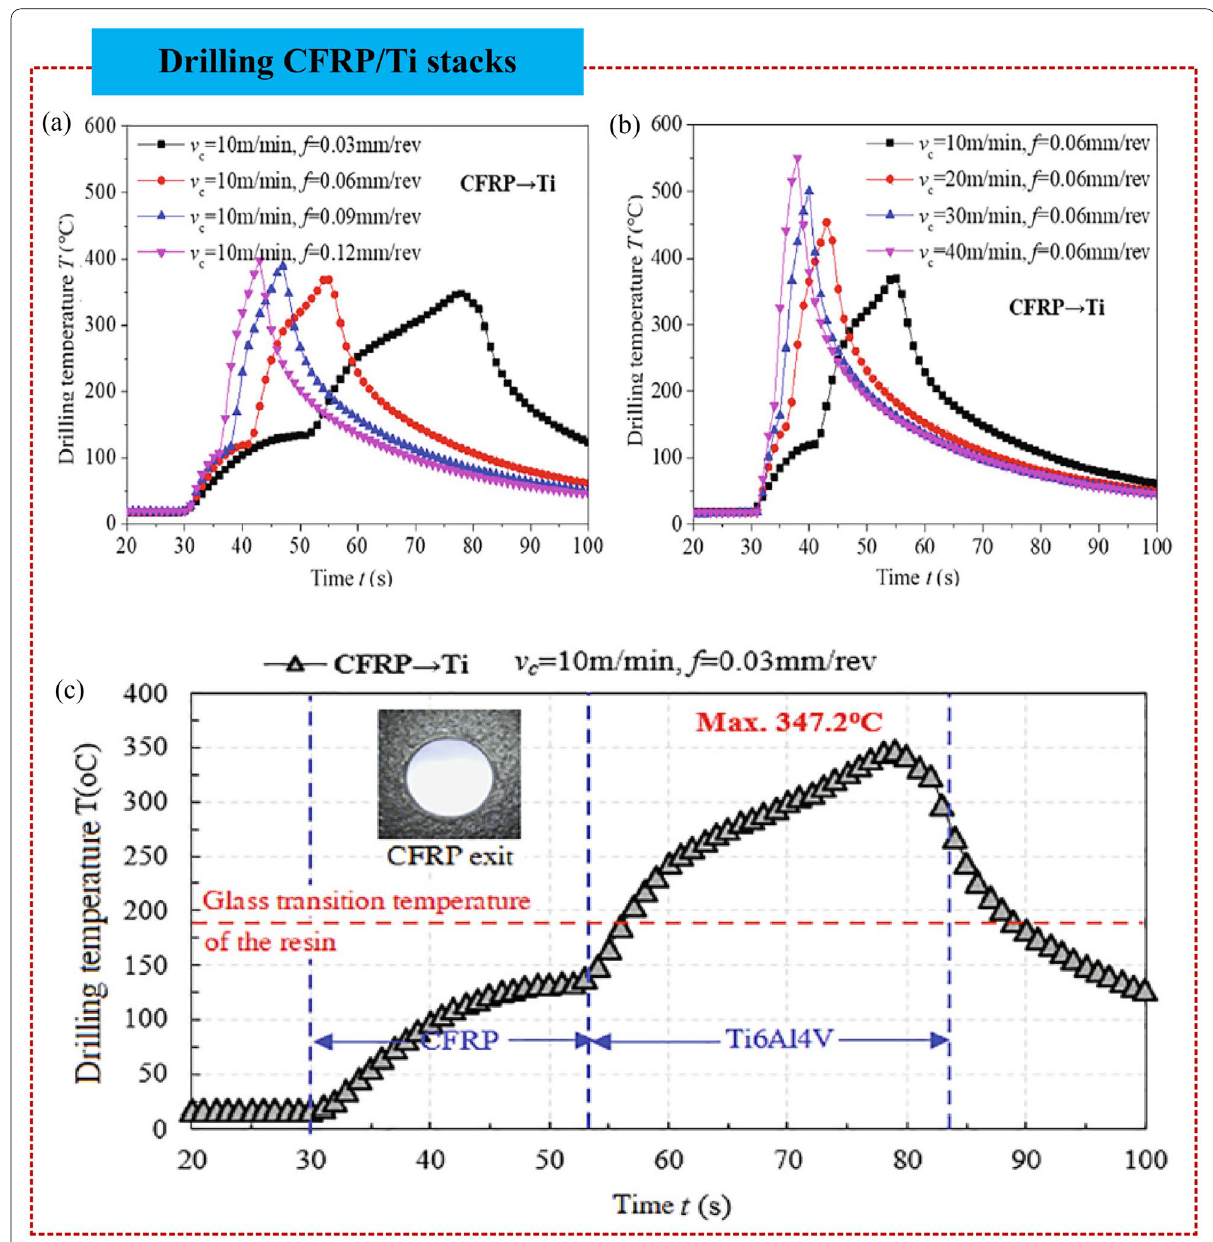
Figure 17 Drilling temperature when drilling CFRP/Ti stacks